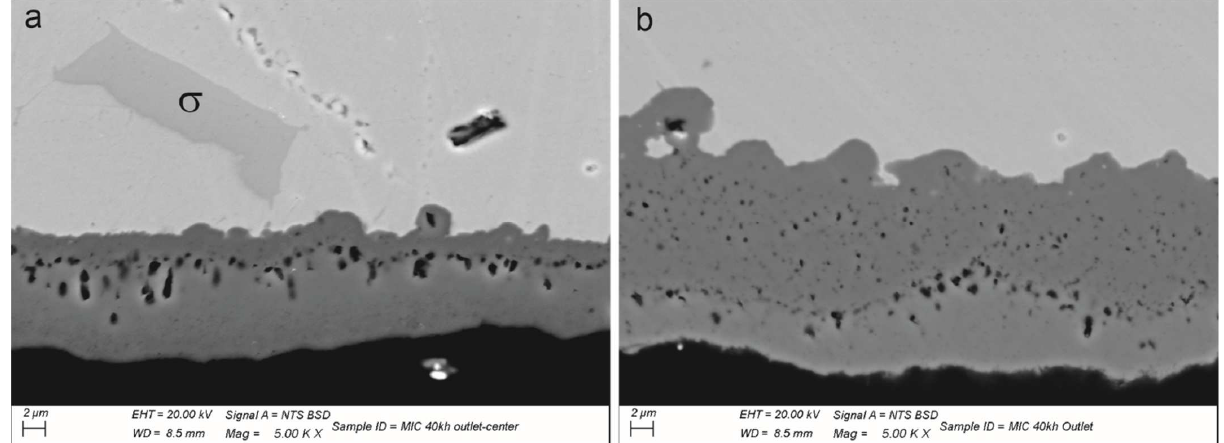
Figure 8 . Quantitative line profile (spectra from 1 to 8 along the black line) and elemental X-ray mapping with a related original micrograph and table showing the increase in Mn content and de- crease in Cr content from the metal substrate to the external oxides. Analyses from 9 to 12 were acquired on the external layer only. The highlighted values show that the average content of Mn is close to 30 at. % therefore related to the MnO 2 stoichiometry.